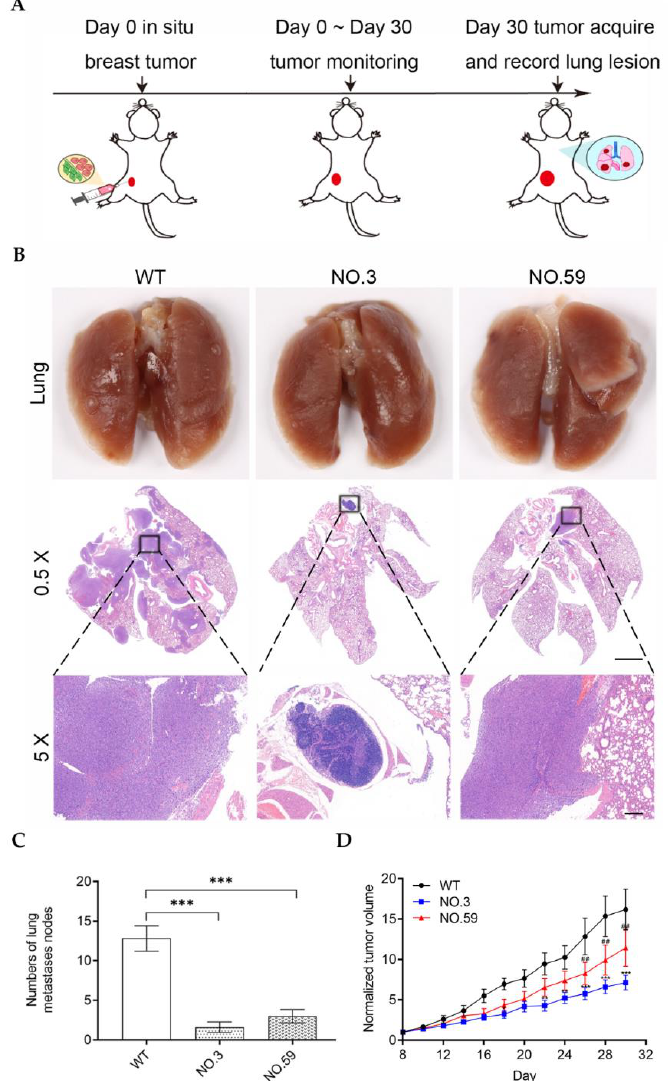
Figure 5. ( A ) Schematic illustration of the mouse experimental procedure for assessing the pulmonary metastasis capabilities of the Cdh2-KO cells in the orthotopic tumor model; ( B ) photographs of the lungs and the H&E staining of the lung sections of mice injected with the wild-type or Cdh2-KO cell lines. 0.5 × magnification, Scale bar: 2 mm. 5 × magnification, Scale bar: 200 µ m. ( C ) The lung nodules were counted under an anatomical microscope. ( n = 5); ( D ) orthotopic tumor growth curves of different groups of tumor-bearing mice. ( n = 5). ‘*’: WT vs. No.3, ‘#’: WT vs. No.59. ** or ## denotes p < 0.01, *** p <